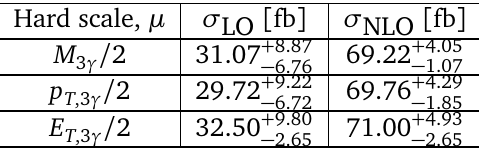
Table 1: Predictions for p + p → γγγ + X total cross section at different choice of factorization / renormalization scale ( µ = µ variation by factor two around the middle values which are listed in first column.